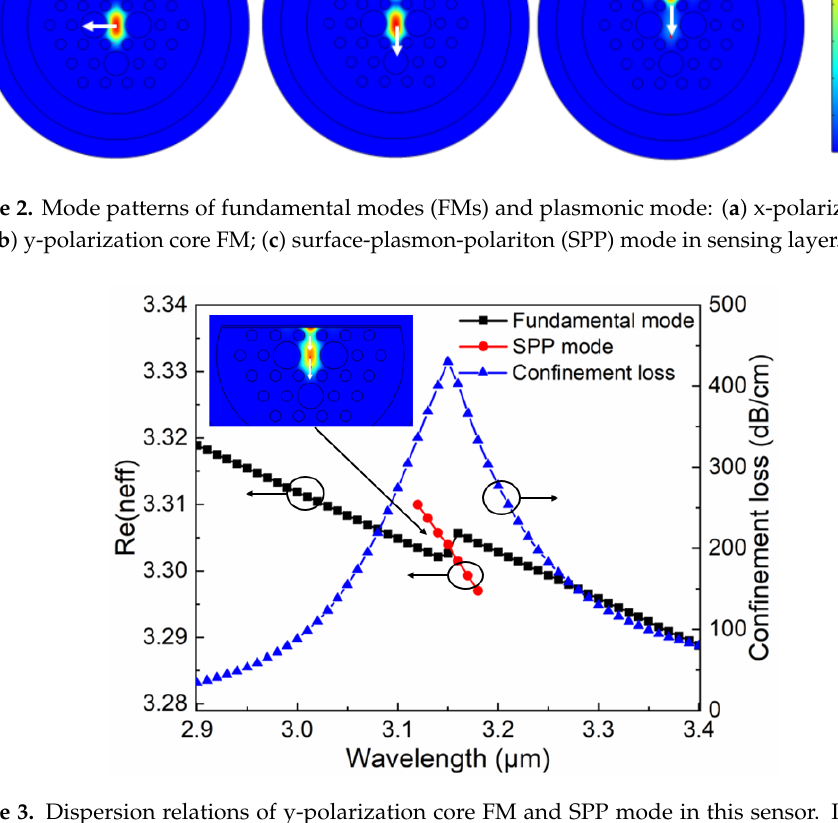
Figure 3. Dispersion relations of y-polarization core FM and SPP mode in this sensor. Illustration of resonance mode displayed when d 1 = 2.8 μ m, d 2 = d 3 = 7.0 μ m, Λ 1 = Λ 2 = 6.0 μ m, T Au = 50 nm, and n a = 1.36.